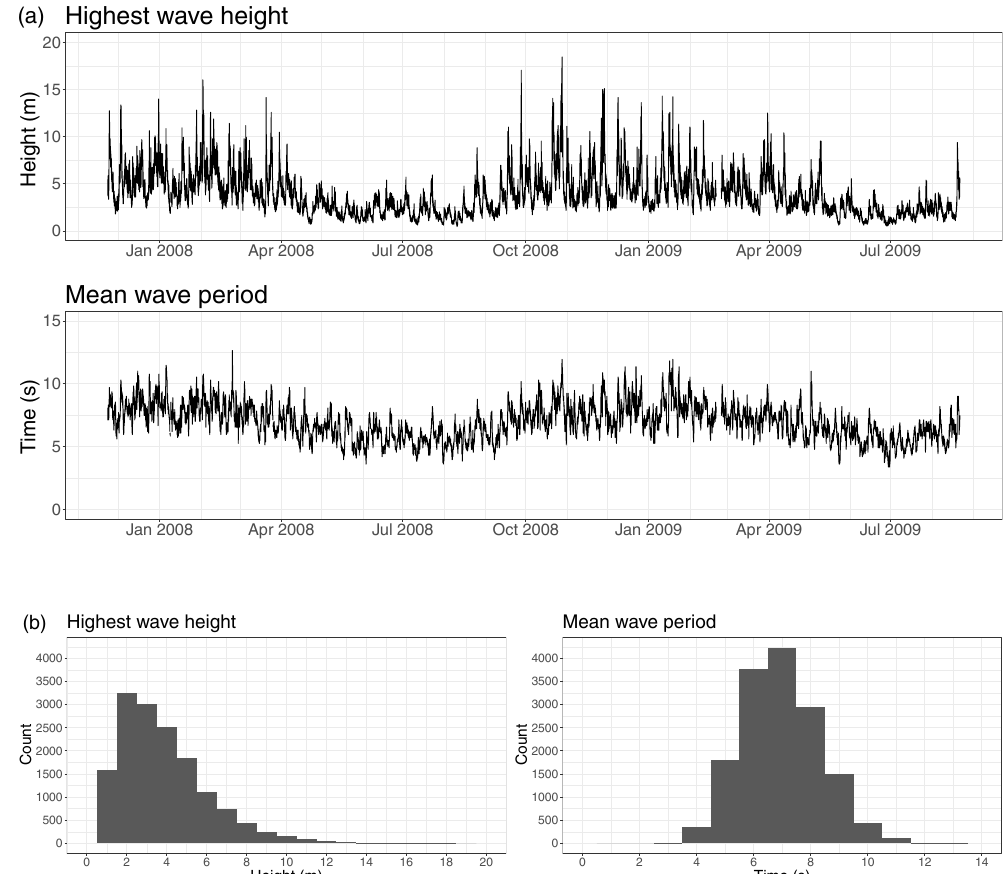
Figure 13. Measurements of the highest wave height (m) and the mean wave period (s). (a) Time series and (b)